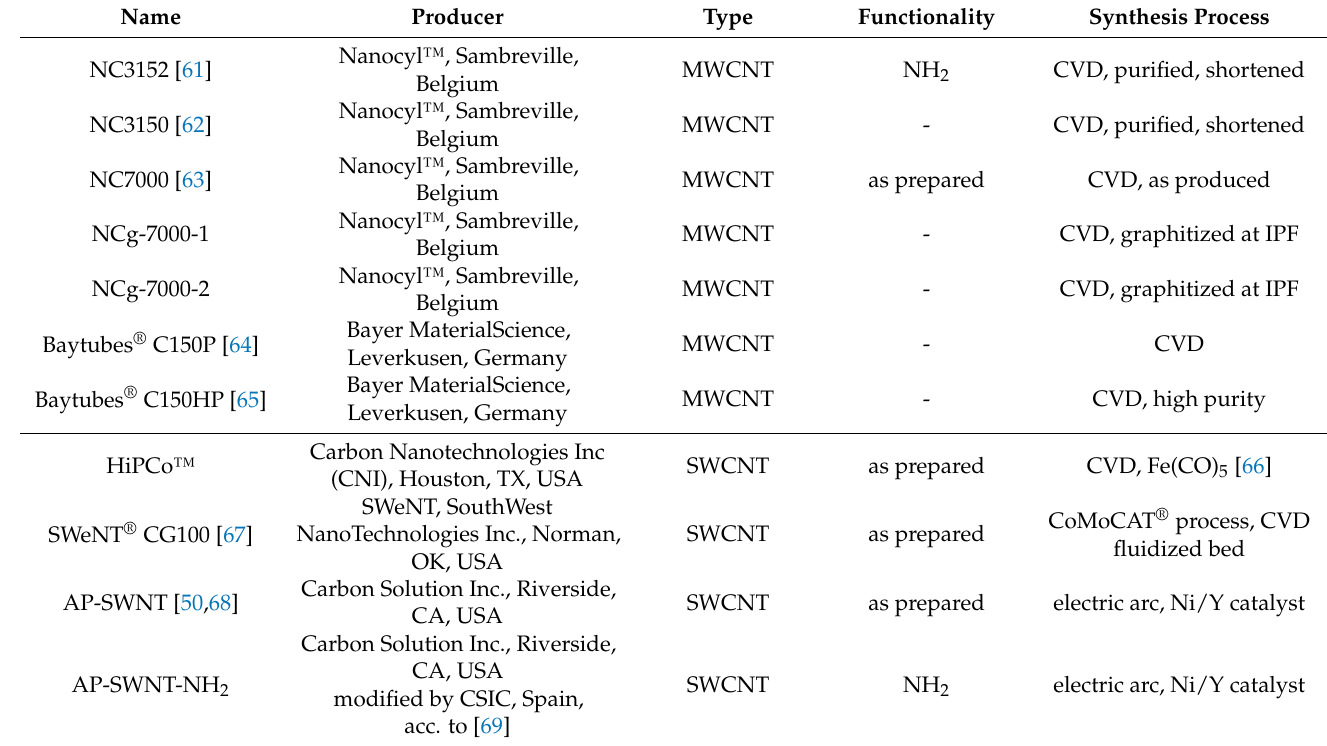
Table 4. List of the employed carbon nanotube